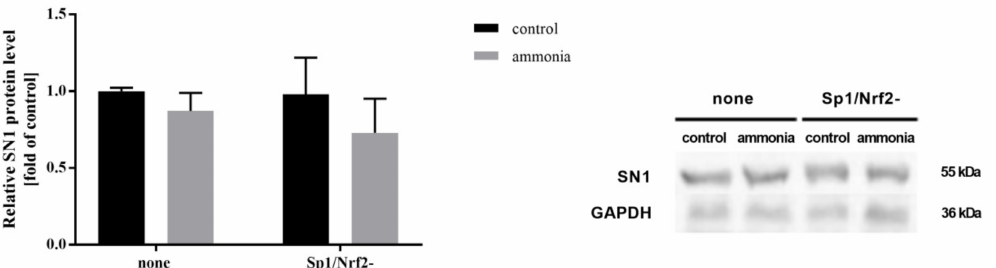
Figure 6. SN1 protein level in astrocytes with inactivated Sp1 and Nrf2 (Sp1/Nrf2-) complex in the absence or presence of 5 mM ammonia. The left panel shows summary for densitometric data, the right panel, a representative immunoblot. Results are the mean ± SD ( n =